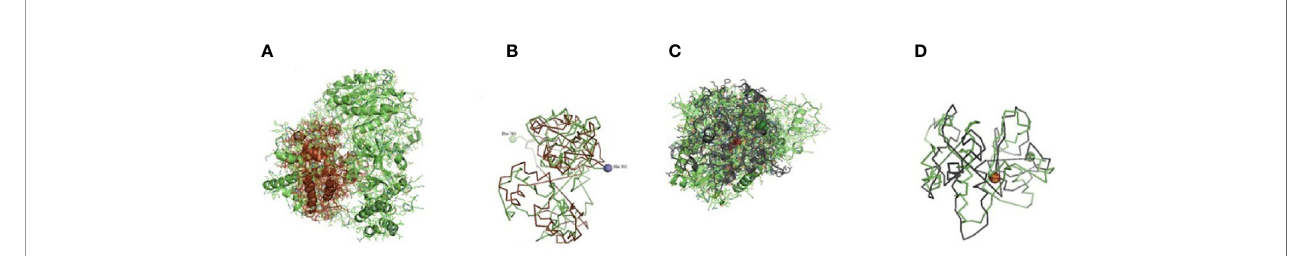
FIGURE 7 | (A, B) Molecular docking of parasitic protein Alpha tubulin with ovine RIG-I, alignment (left) and binding site (right). (C, D) Molecular docking of parasitic protein Glc 5 with ovine RIG-I.